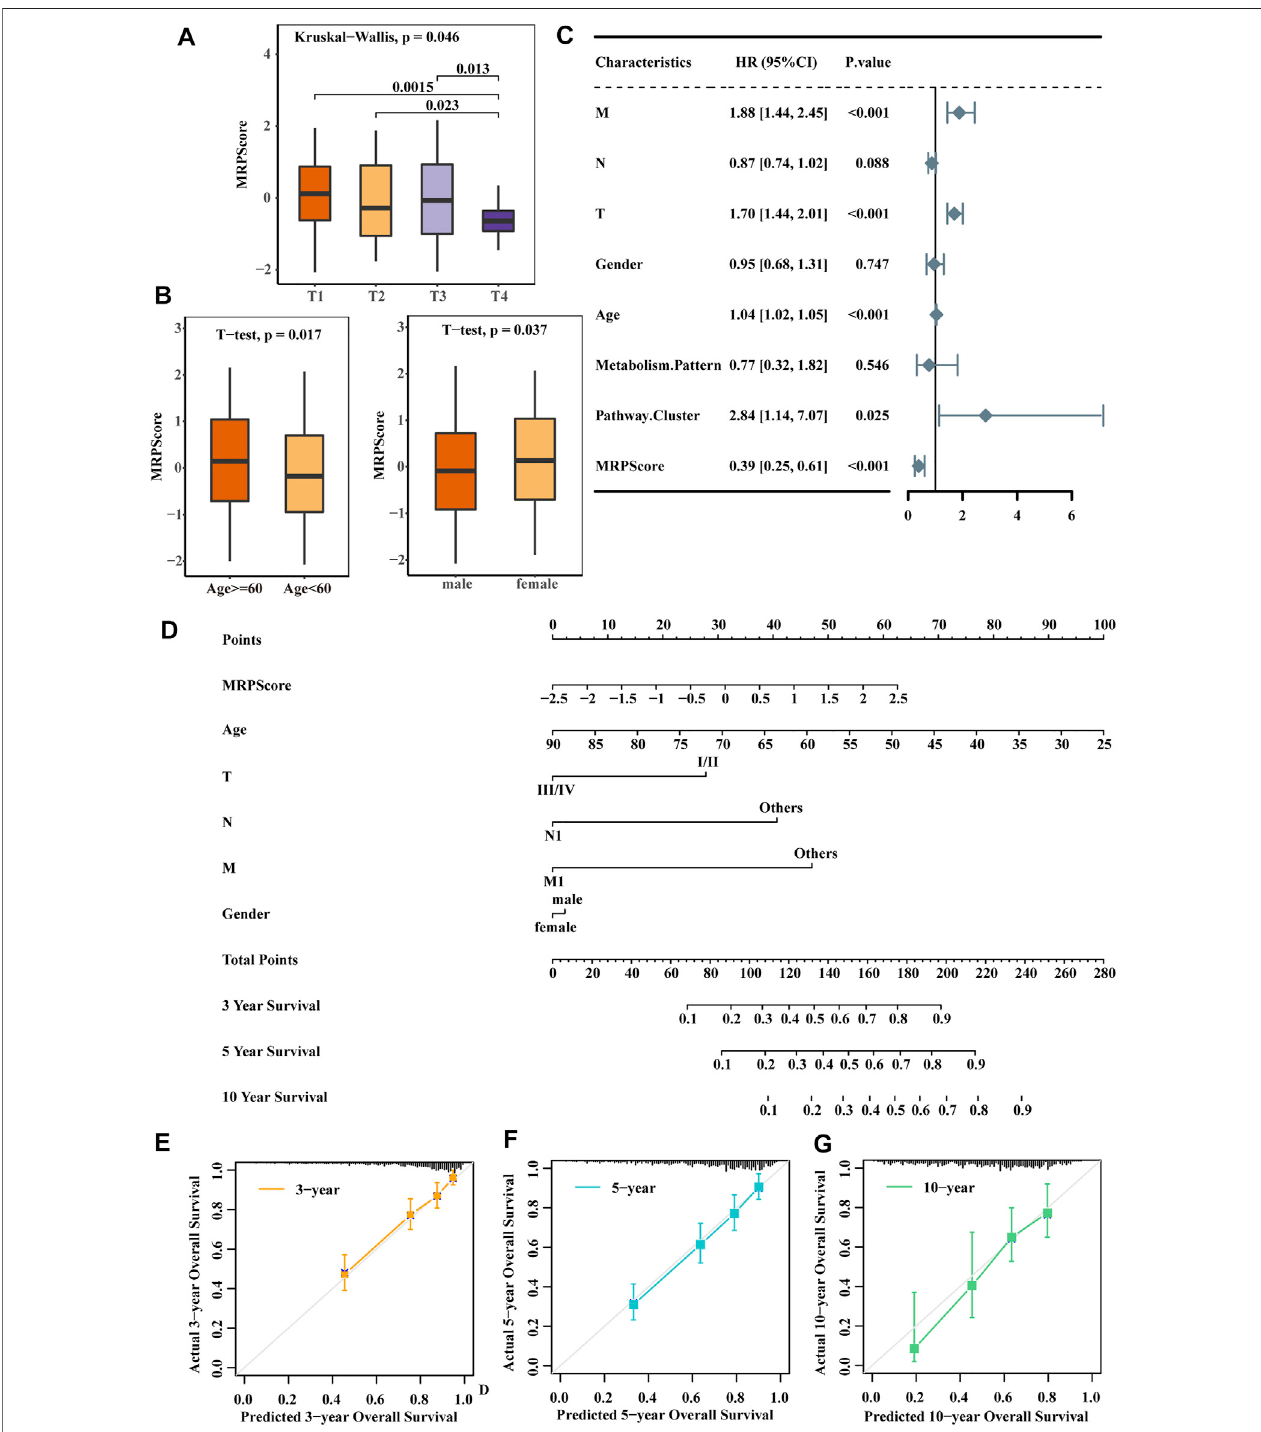
FIGURE 5 | The MRPScore acted as a risk factor for RCC. (A) Differences in the MRPScores between the different T stages. The Kruskal – Wallis test was used to compare the signi fi cant differences between the 4T stages. The asterisks represent a statistically signi fi cant p value (* p < 0.05; ** p < 0.01; *** p < 0.001; **** p < 0.0001). (B) DifferencesintheMRPScoresbetweenthedifferentages(left)andsexes(right).The t testwasusedtocomparethesigni fi cantdifferences. p valuesweredetermined by a student ’ s t test. (C) Multivariate Cox regression analysis results show the association between the clinicopathological parameters, such as age, sex, T stage (T),tumourlymphnode(N),tumourmetastasis(M),andMRPScore,ofthenewsurvivalmodelandtheOSofKIRCpatients. (D) Nomogramconstructionforthe3-,5-and 10-years OS prediction for KIRC patients. (E – G) Calibration curve analysis of the nomogram for predicting 3- (E) , 5- (F) and 10- (G) year OS in the TCGA-KIRC dataset.